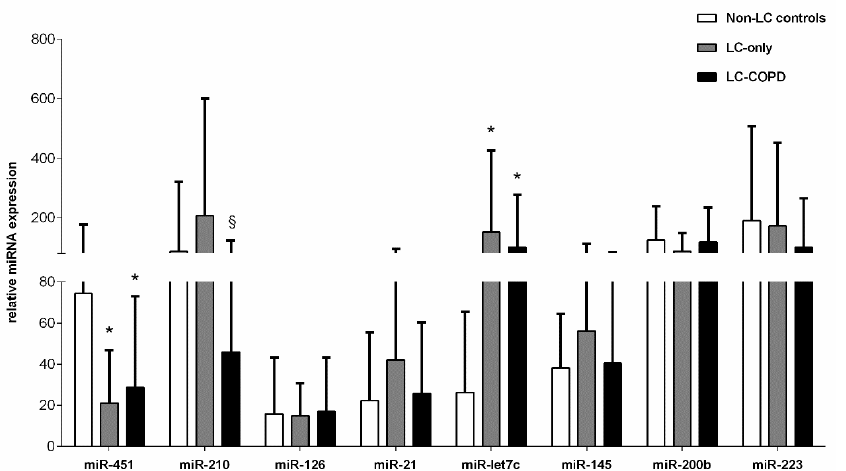
Figure 1. Mean values and standard deviation (relative expression) of microRNA (miR) expression in plasma samples of non-LC controls (white bars), LC-only patients (grey bars), and LC-COPD patients (black bars). Statistical significance: * p < 0.05 between either of the two groups of patients with LC and the non-LC control subjects; § p < 0.05 for comparisons between LC-only patients and LC-COPD patients. For the sake of clarity, the absence of statistical symbols indicates that no significant differences were found between groups for the different study comparisons.